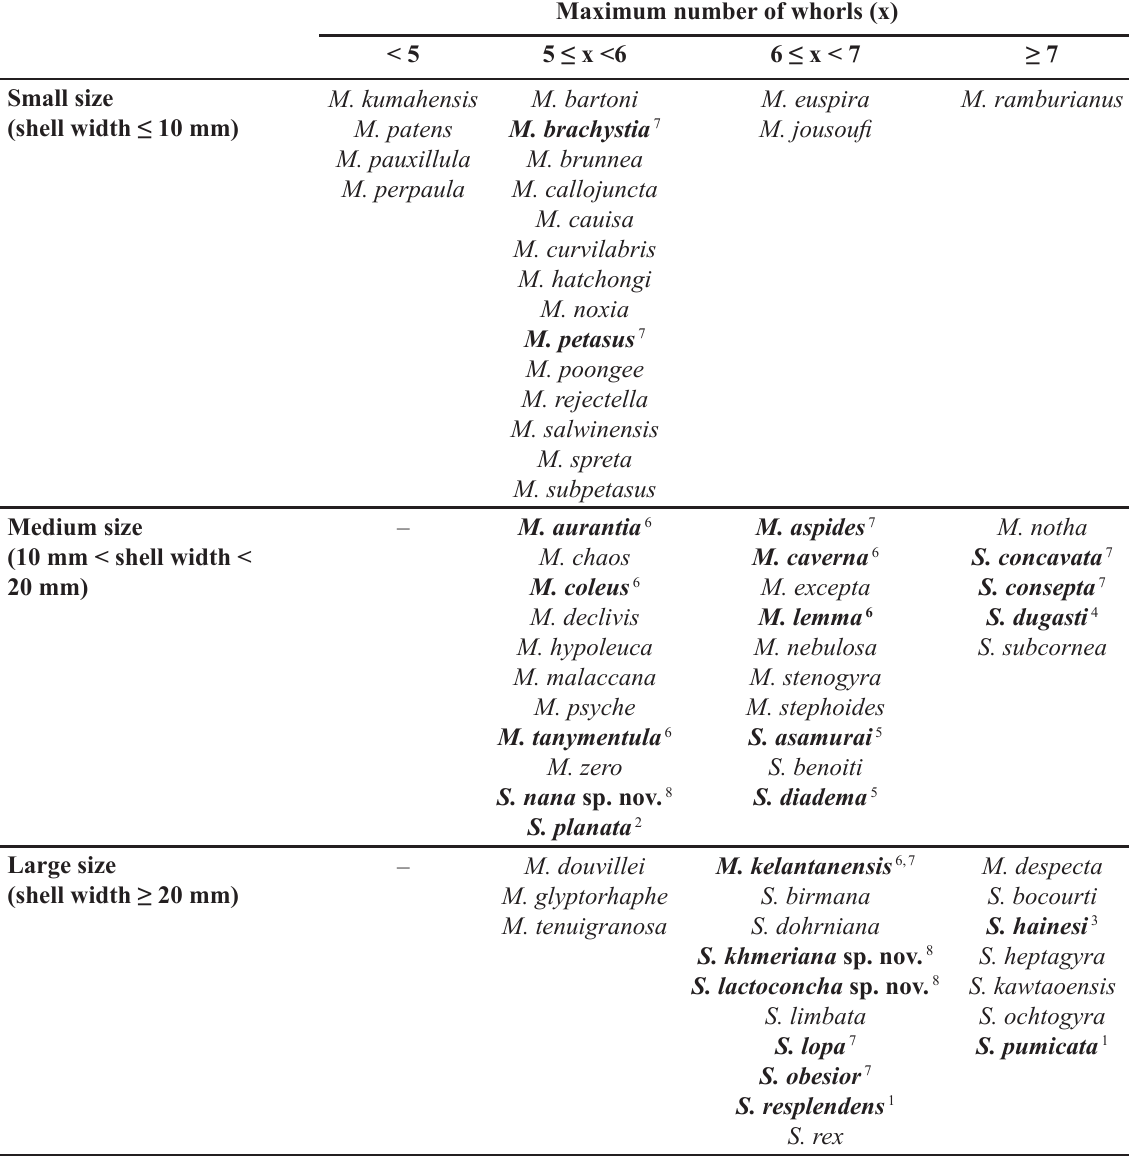
Table 1. Taxa attributed to Macrochlamys and Sarika from mainland Southeast Asia, as classified by their maximum shell width and maximum whorl numbers. Data are taken from the original descriptions and additional references. Taxa in bold are confirmed in generic placement by genital characters. 1 Godwin- Austen (1907) and Blanford & Godwin-Austen (1908); 2 Laidlaw (1933); 3 Solem (1966); 4 Maneevong (2000); 5 Sutcharit & Panha (2008): 6 Pholyotha et al. (2018); 7 Pholyotha et al. (2020); 8 This